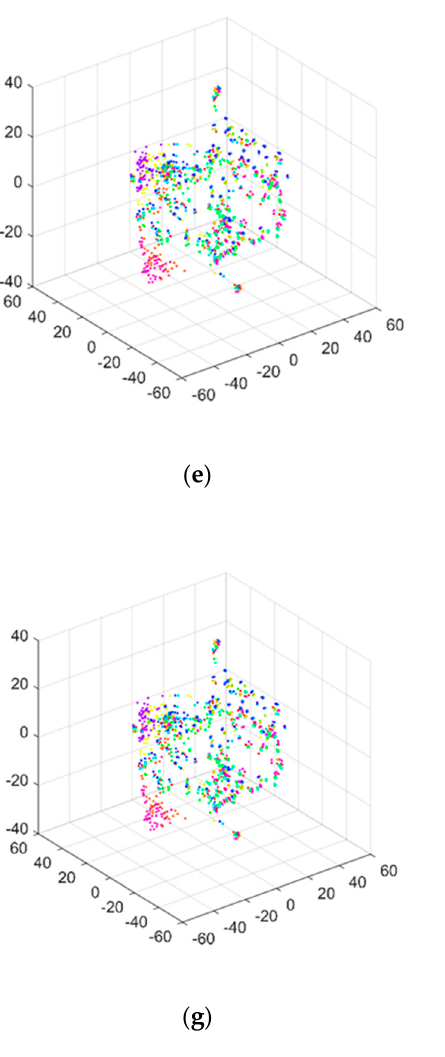
Figure 14. Visualization results of the features in the FFT-based signals extracted by the 1D CNN model under the noise levels of SNR = ( a ) 50, ( b ) 40, ( c ) 35, ( d ) 30, ( e ) 25, ( f ) 20, ( g ) 15, and ( h ) 10 dB.